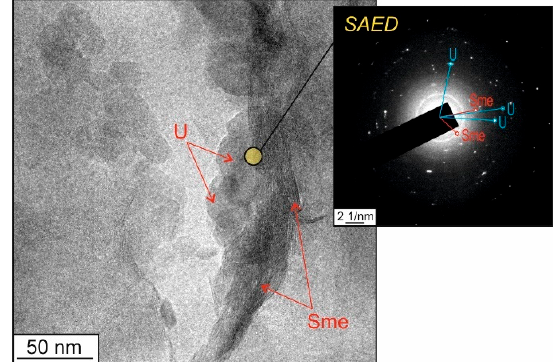
Figure 3. Transmission electron microscopy (TEM) images with selected area electron diffraction (SAED) patterns showing smectite (Sme) and urea (U) crystallite for S3N2pm11 composite. The composites of S3N2pm3/8/11 (Figure 4) show minor changes of low of CO at 790 cm − 1 and Si-O stretching at 1050 cm − 1 . All composites show a gentle peak at 720 cm − 1 (NH 2 ). The NH 2 peak is identified at 1155 cm − 1 in all the composites. Composites exhibit the asymmetric deformation of the C–N at 1463 cm − 1 . Peaks at 1629–1650 cm − 1 (NH 2 ) and the flat 1662–1683 cm − 1 (NH) are distinctive of the composites. These two peaks appear stronger in S3N2pm11 compared to S3N2pm 3/8. FTIR peaks of S3N2pm11 characteristically exhibit a peak at 3344 cm − 1 , probably reflecting the nitrogen coating. The NH 2 peak shifts from 3485 to 3440 cm − 1 with increasing grinding time. All composites show a peak of 3620 cm − 1 , which is associated with IR-vibration Al-OH-Al of montmorillonite. Figure 4. FTIR spectra of the S3N2pm composites. Note the systematic shifts in spectral characteristics of composites with increasing grinding time compared to smectite (montmorillonite). The composites are characterized by six weight loss steps on the thermogravimetric (TG) curves: 0–135 °C, 135–240 °C, 240–300 °C, 300–450 °C, 450–580 °C, and 580–1000 °C (Figure 5, Table 1). The curves of composites exhibit weight losses by 0.8–1.1% and 20.4– 21.0% in the steps of 20–135 °C and 135–240 °C, because of the release of free water and adsorbed urea, respectively [49,50]. The third and fourth weight loss steps at 240–300 °C and 300–450 °C indicate the decomposition of absorbed and intercalated urea, respectively [39,51]. The absorbed urea (within smectite micro-aggregates) is removed by weight losses of 3.2–3.7% (equal to 8–9.2% of used urea) in a weight loss range of 240–300 °C. Part of the intercalated urea is lost by 12.9–13.6% in a step of 300–450 °C. The fifth step at the temperature range of 450–590 °C corresponds to the removal of intercalated urea [52] by